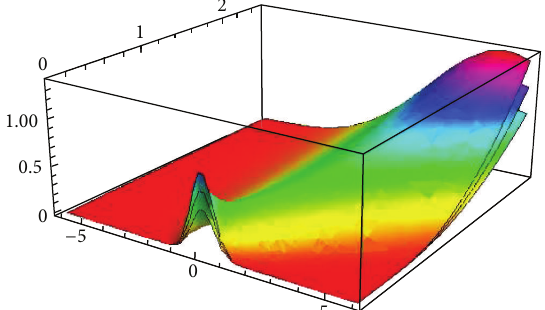
Figure 3: Graph of the fuzzy solution for 𝑎,𝑏 ̸= 0 .